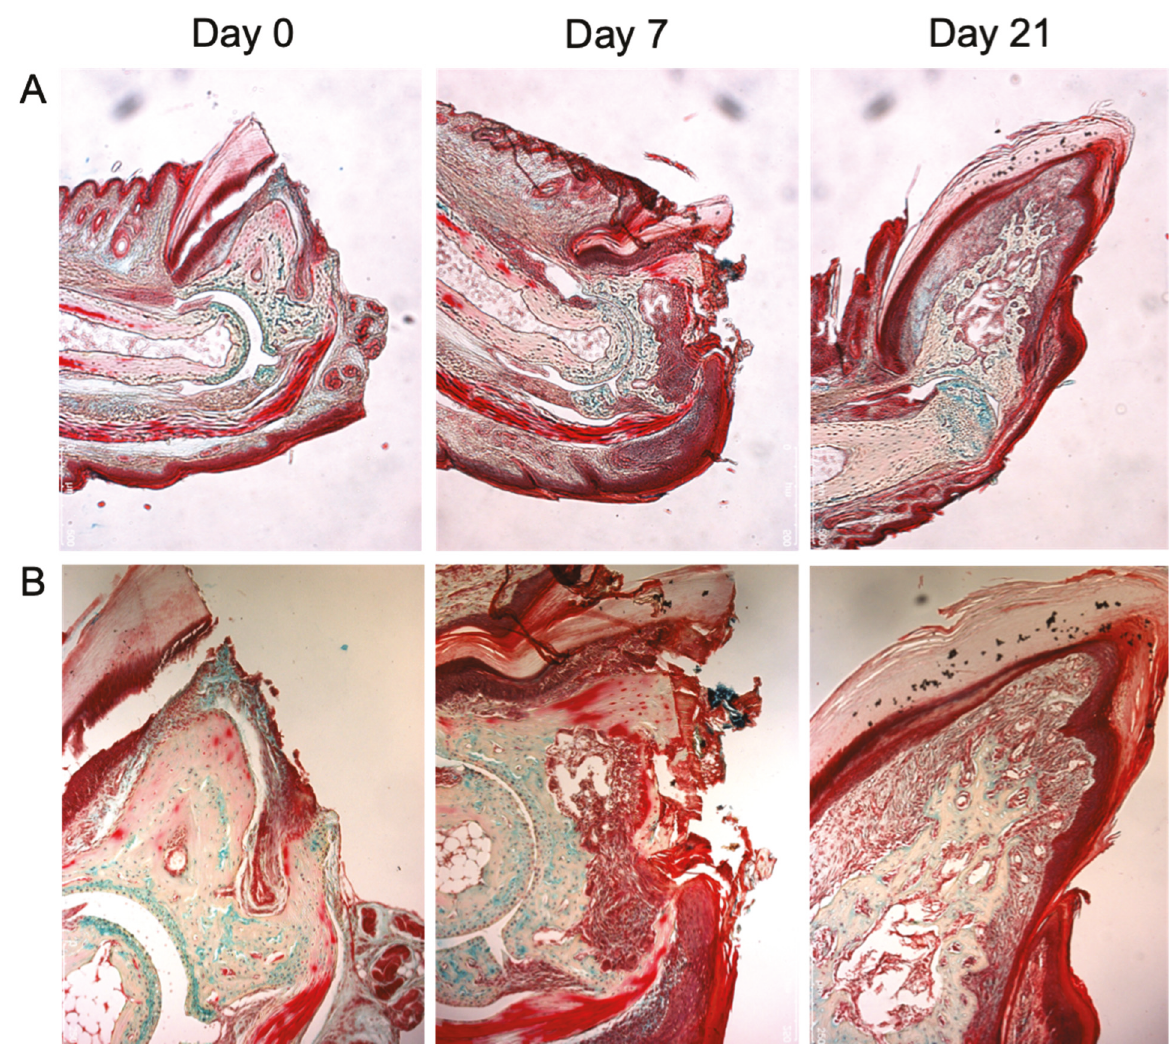
Figure 1: Regenerating adult mouse digit after sharp amputation through P3. By day 21, the digit structure and all of its native tissue types are restored. (a) 5x magni fi cation; (b) 10x magni fi